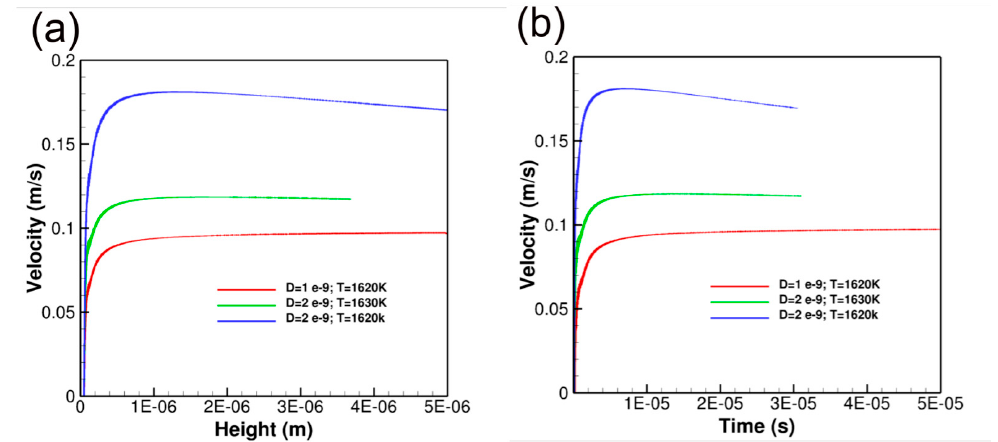
Figure 8. Growth curves for steady-state solidification in 3D as a function of ( a ) height and ( b ) solidification time with a thermal gradient of 2.6 × 10 6 K/m in the liquid and different steady-state s-l interface velocities.